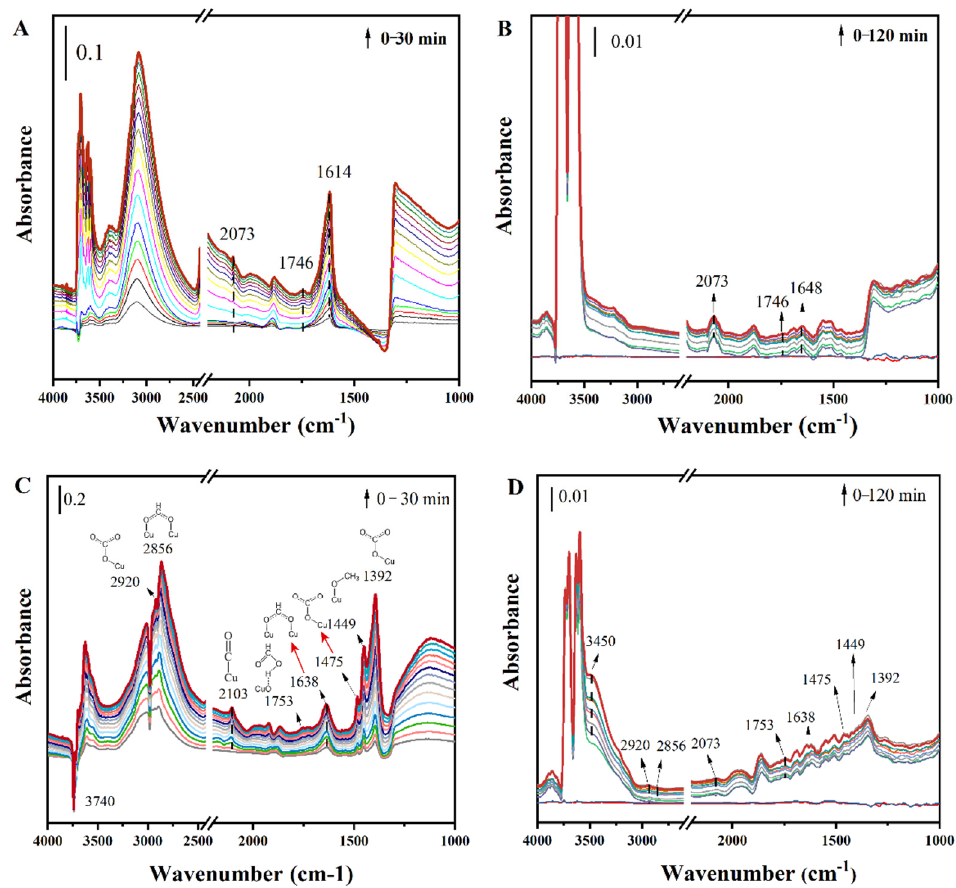
Figure 6. In situ FTIR of reduced Cu 2.1 @NS at room temperature and 150 °C in 20 mL/min. ( A , B ) CO 2 flow; ( C , D ) CO 2 +3H 2 flow at the atmospheric pressure.